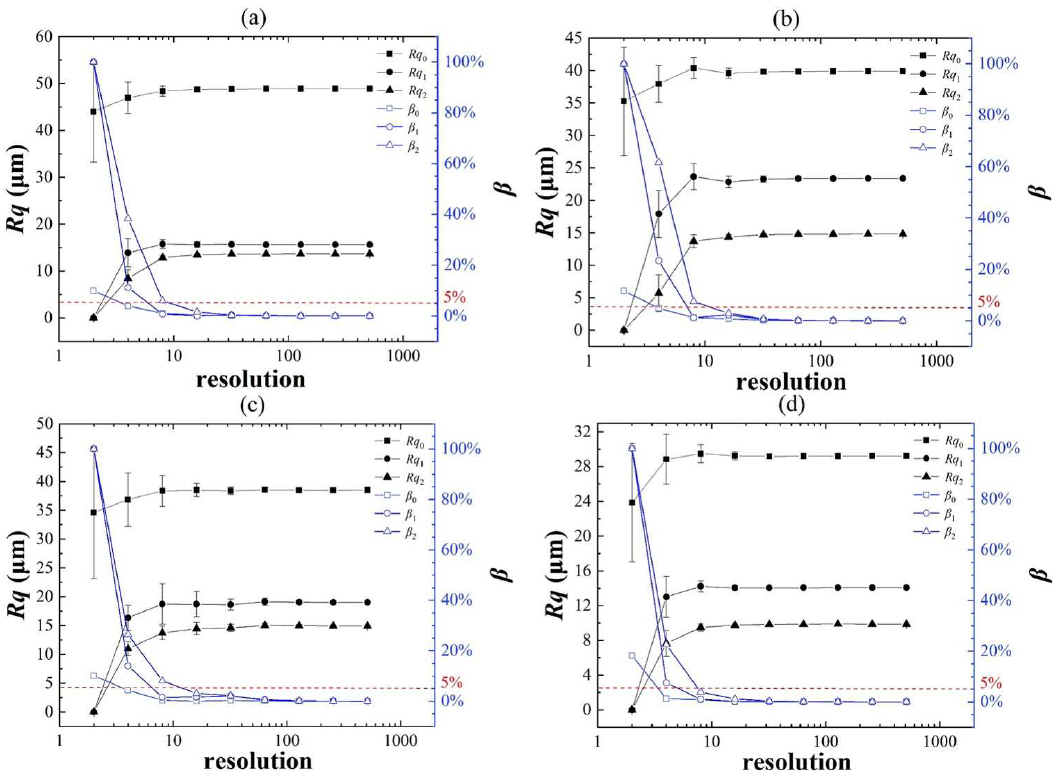
Figure 6. Rq values obtained by using different number of picture elements and flatten orders for the artificial surfaces shown in Figure 1. The β values were calculated through Equation (4) to qualify the Rq variations. ( a ) D i = 2.2; ( b ) D i = 2.4; ( c ) D i = 2.6; ( d ) D i =